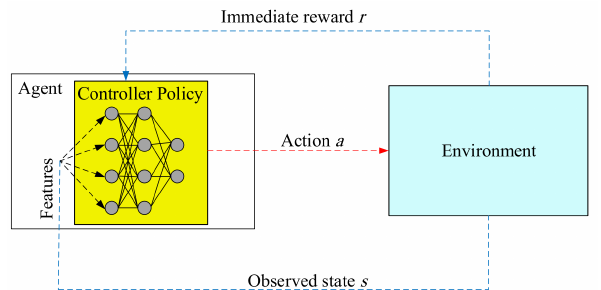
Figure 12. Deep reinforcement learning system.